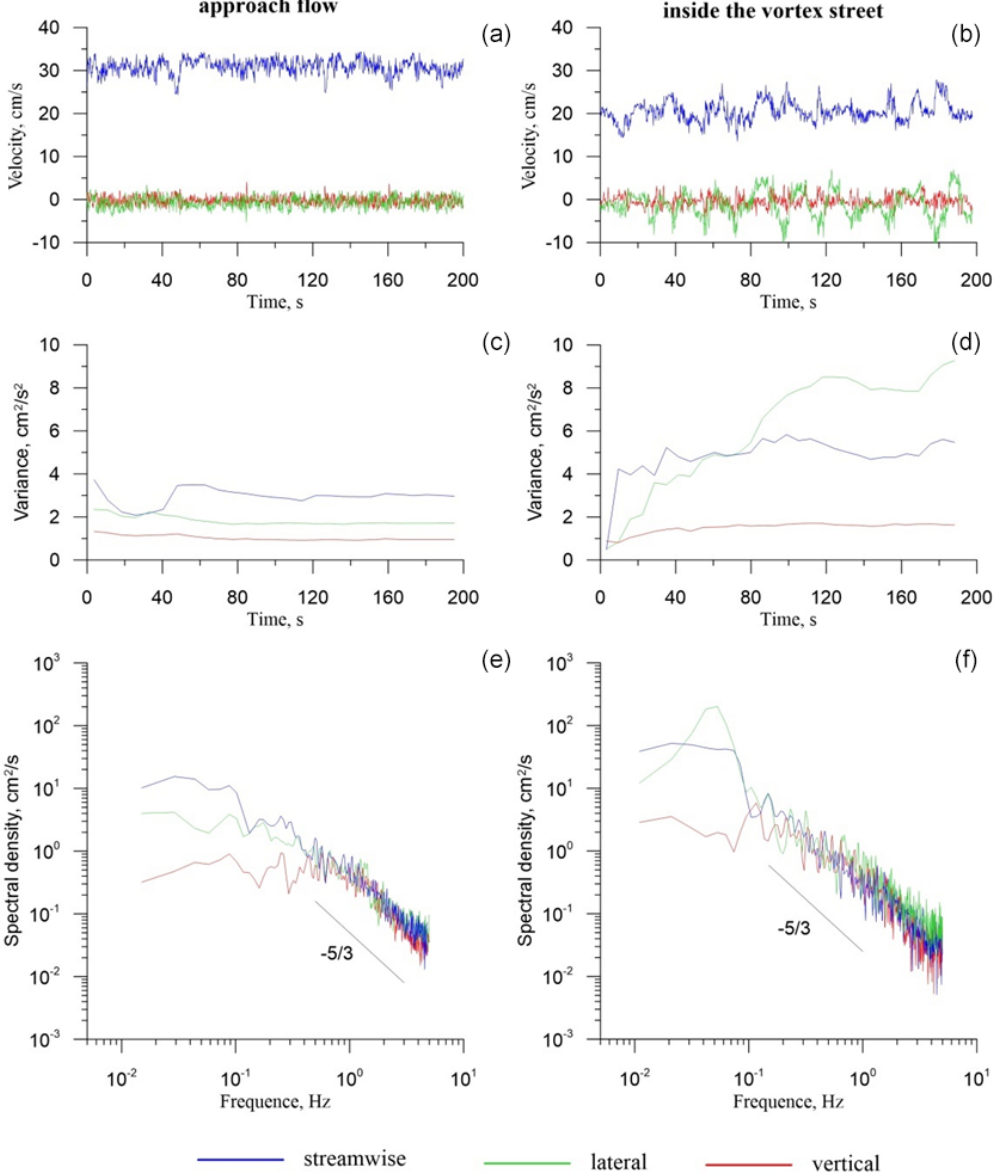
Figure 7. Examples of measured velocity data: (a) time series of 3-D velocities, (b) cumulative variances as a function of the band period and (c) turbulence